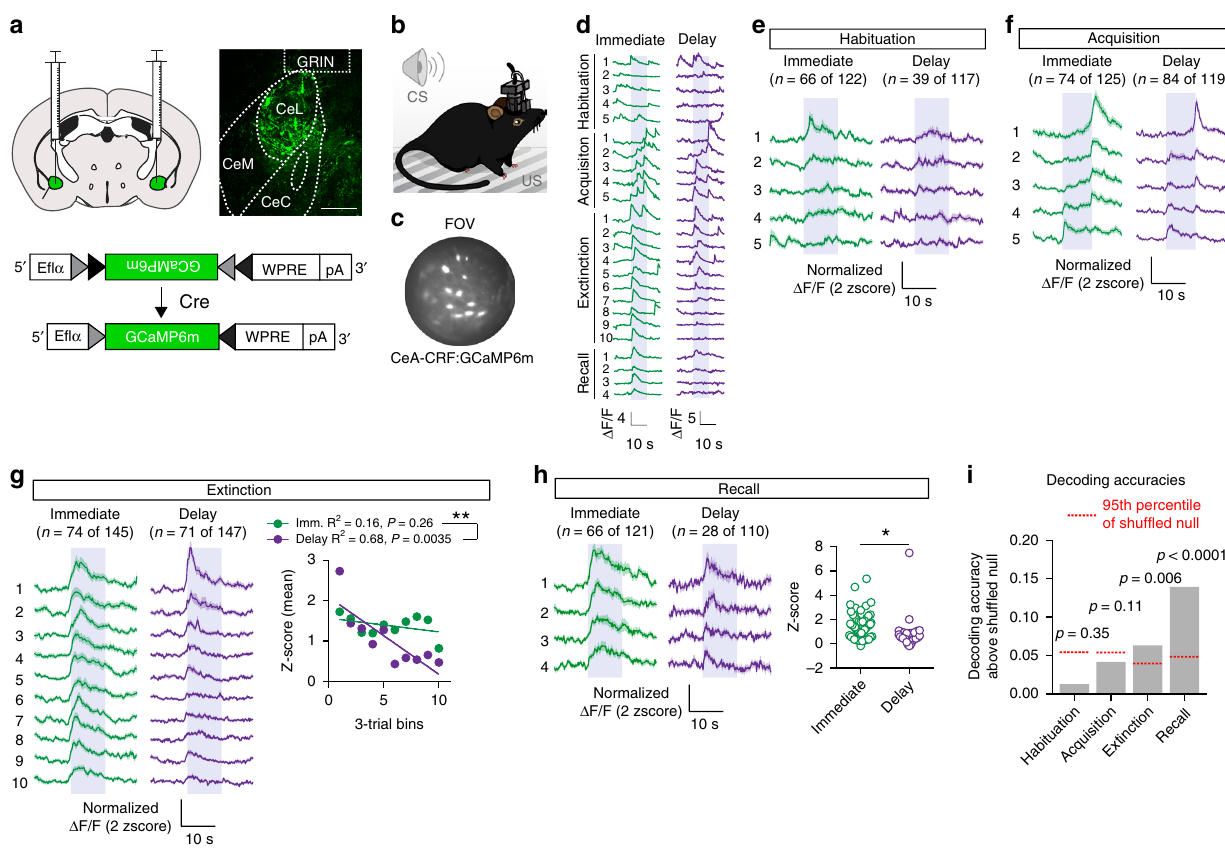
Fig. 4 Imaging CeA – CRF neurons during fear conditioning and extinction. a AAV1-FLEX-GCaMP6m injection into the CeA and representative immunohistochemical veri fi cation of GCaMP6m expression and GRIN lens placement in the CeA. Scale: 250 μ m. CeM central amygdala medial, CeL lateral, and CeC capsule. b Cartoon illustrating mouse with miniscope implantation and conditioning chamber. c Fluorescence fi eld-of-view (FOV) from miniscope of GCaMP6m-expressing CeA – CRF neurons. d Representative individual cell responses during each of the four sessions, habituation, acquisition, extinction, or recall, blue bar denotes CS presentation. e Average normalized calcium (±S.E.M.) signals of CeA – CRF neurons that responded to the initial CS presentation during habituation ( n = 24, 38, and 4 cells from each mouse immediate extinction and n = 13, 21, and 5 cells from each mouse delay extinction). f Average normalized calcium signals (±S.E.M.) of CeA – CRF neurons that were activated during acquisition ( n = 37, 33, and 4 cells from each mouse immediate extinction and n = 43, 35 and 6 cells from each mouse delay extinction). g Average normalized calcium signals (±S.E.M.) of CeA – CRF neurons that responded to the CS presentation during extinction ( n = 26, 36, and 12 cells from each mouse immediate extinction and n = 25, 35 and 11 cells from each mouse delay extinction). Linear regression analysis of the mean calcium signal (averaged across 5 s period following CS onset) and extinction trial was signi fi cant for the delay extinction group ( P = 0.0035), but not the immediate extinction group ( P = 0.26). There was a signi fi cant difference between the slopes (** P = 0.01). h Average normalized calcium signals (±S.E.M.) of CeA – CRF neurons that responded to the CS presentation during recall ( n = 12, 35, and 19 cells from each mouse immediate extinction and n = 15, 7 and 6 cells from each mouse delay extinction). The average CS-evoked response (averaged across 5 s period following CS onset, ±S.E.M.) across the four trials is signi fi cantly different between the groups (Unpaired Student ’ s t - test, * P < 0.05). i CS-responsive cells during extinction training and recall were accurate at decoding behavioral groups relative to the shuf fl ed null distribution. CS-responsive cells during habituation and acquisition were not signi fi cantly accurate decoders. P-values shown are one-tailed since the alternative hypothesis is accuracy, which is higher than extinction group (Fig. 4g, F (1,16) = 8.29, P = 0.01). We also observed a signi fi cant difference in the average calcium